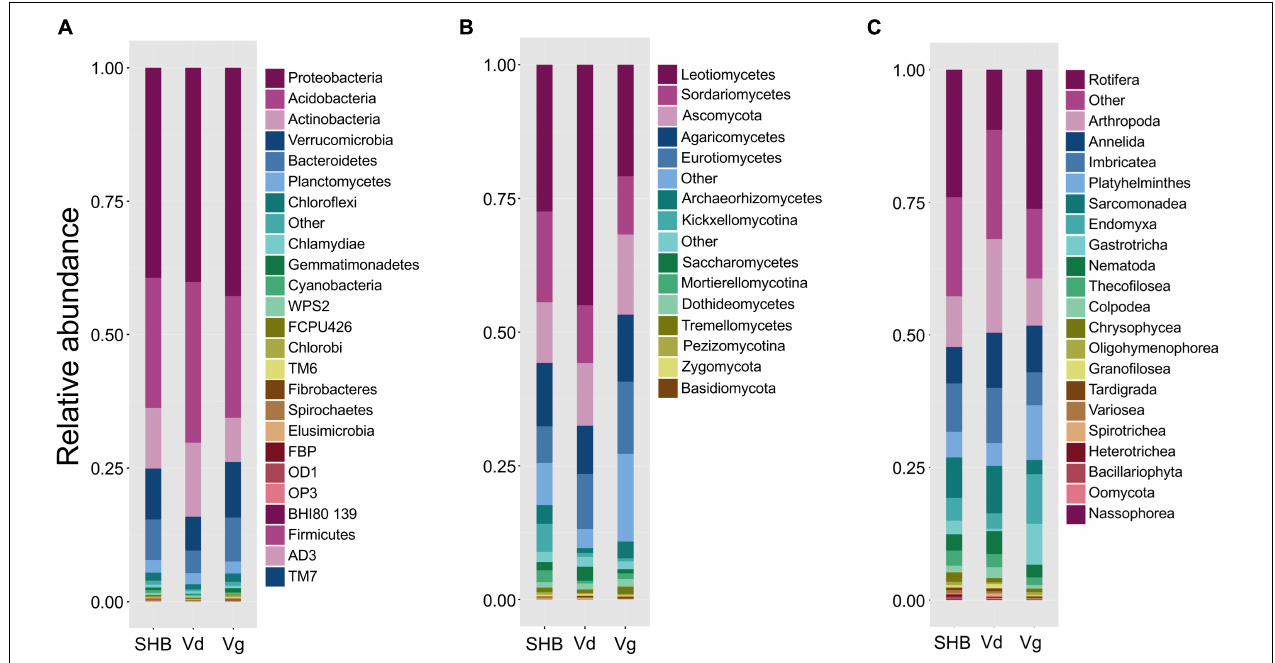
FIGURE 1 | The relative abundance of major bacterial (phylum level) (A) , fungal (class level) (B) , and non-fungal eukaryotic (class level) (C) taxa present in the rhizosphere of different blueberry